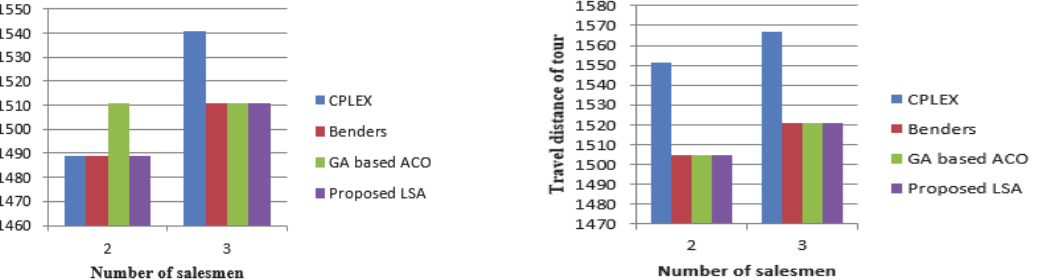
Fig. 6. Comparison of travel distance for ftv35 by considering two and three salesmen